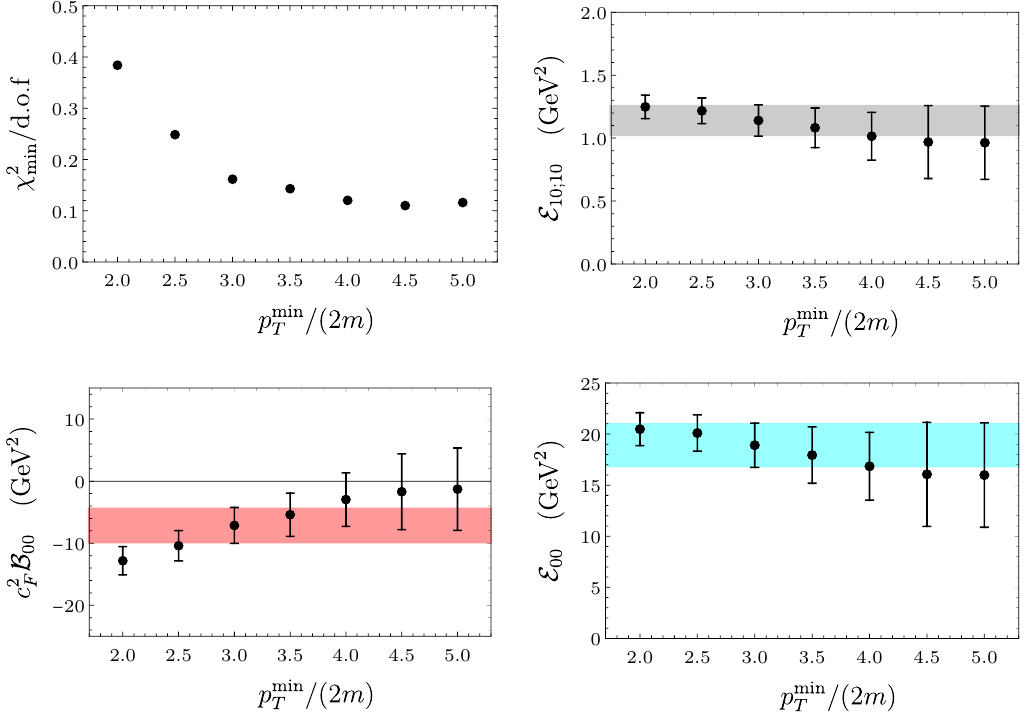
Figure 5 . Dependence on the lower p T cut p min and E 00 determined from fits to cross section data. The E 10;10 and B 00 are renormalized in the MS scheme at the scale Λ = 1 . 5 GeV, and c F is computed at the same scale with the charm quark mass m c = 1 . 5 GeV. The bands represent the results of the fit for p min